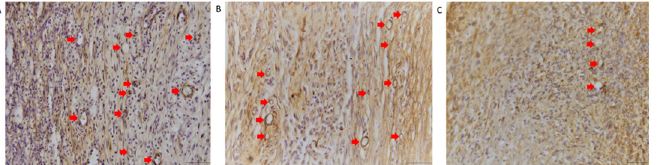
Fig 9. Microscopic view of new blood vessel formation in areas of granulation. Myofibroblasts and pericytes were stained brown because they contain α -SMA. Blood vessels are circular in shape and their walls containing pericytes are brown (arrows). Therefore, it is possible to distinguish between myofibroblasts and blood vessels (A) The formation of new blood vessels in the DM-Plasma group on day 7. (B) The formation of new blood vessels in the DM+Plasma group on day 7. (C) The formation of new blood vessels in the DM+Hydrocolloid group on day 7. Scale bar, 50 μ m. Anti- α - SMA stain.